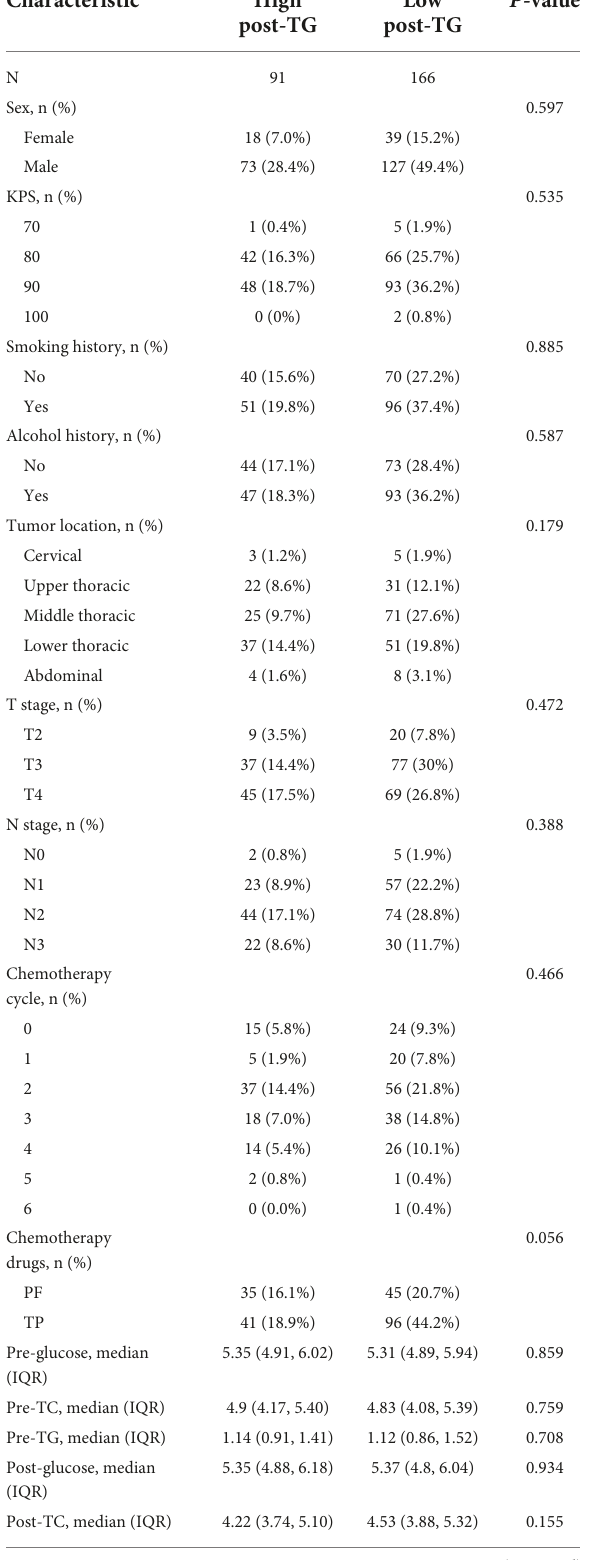
TABLE 4 Demographic and clinical characteristics of cancer patients stratified by post-triglyceride (TG).